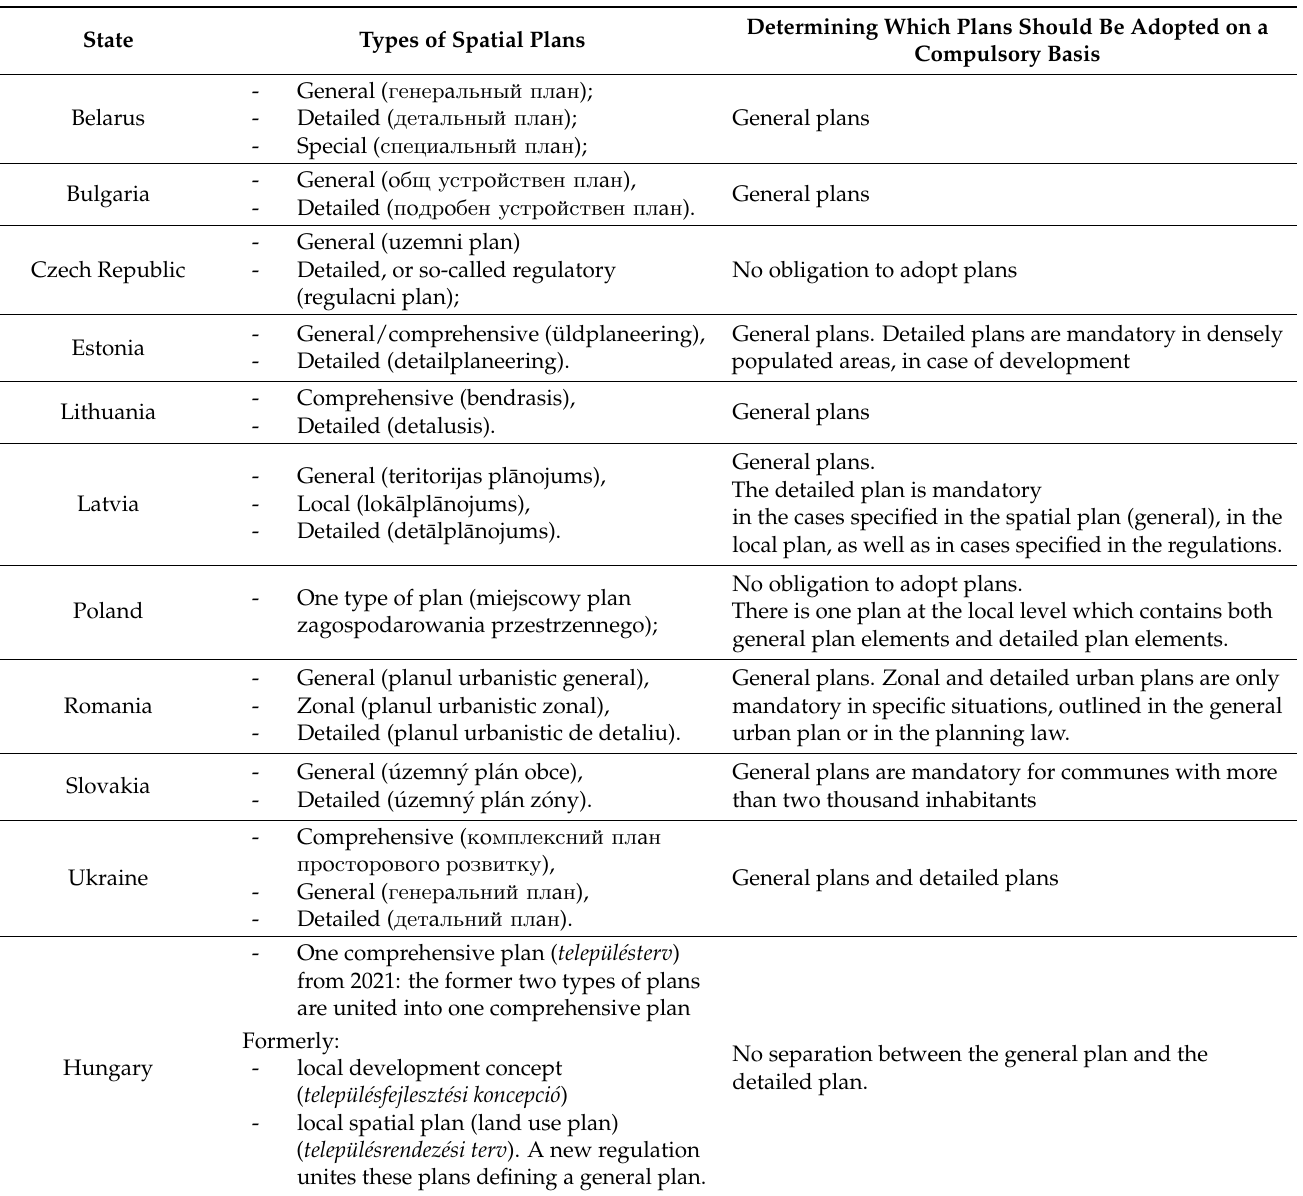
Table 3. Types of spatial plans at the local level and the obligation to adopt